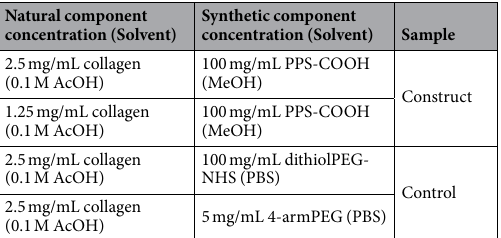
Table 2. Experimental concentration ratio ranges for fabrication of composite hollow